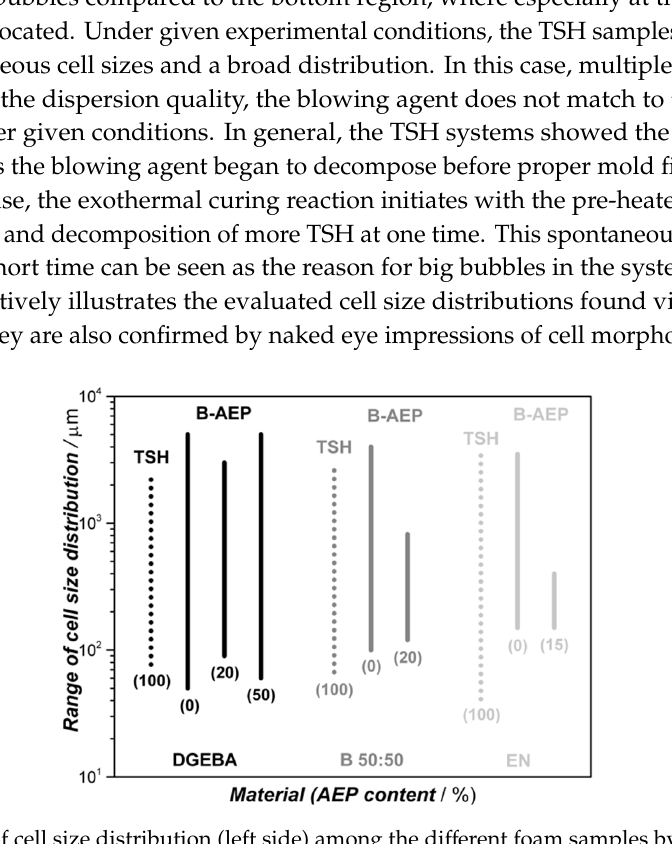
Figure 9. Range of cell size distribution (left side) among the different foam samples by resin and AEP content (percentage of AEP in brackets below the lines). Dotted lines represent the use of only TSH as the blowing agent. Shorter lines illustrate a smaller cell size distribution.